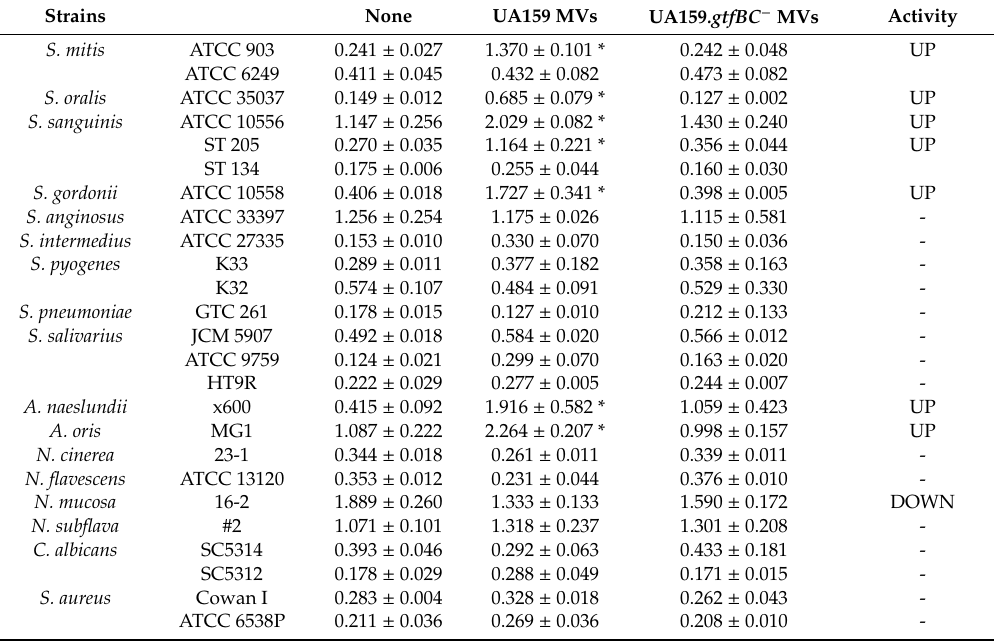
Table 1. GTF-I and GTF-SI on biofilm formation in oral microorganisms. Strains